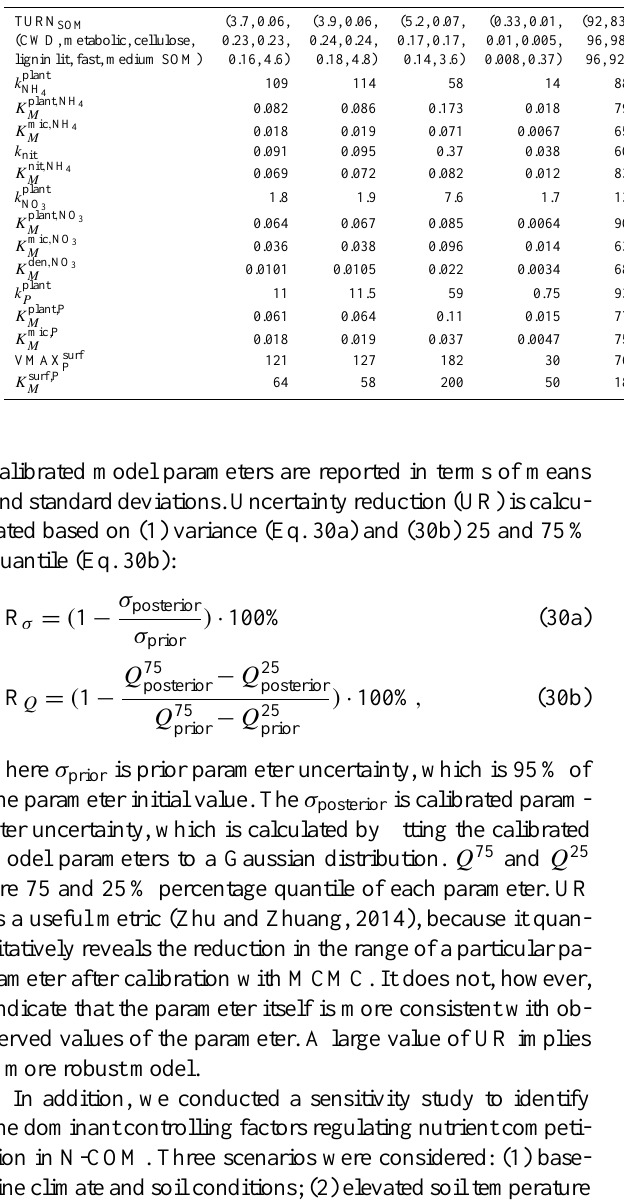
Table 4. Calibrated parameters are reported in terms of (1) mean/standard deviation by fitting to a Gaussian distribution; (2) 25 and 75% quantile. Both variance-based and quantile-based parameters uncertainty reduction are provided; (3) Gelman–Rubin convergence criterion.